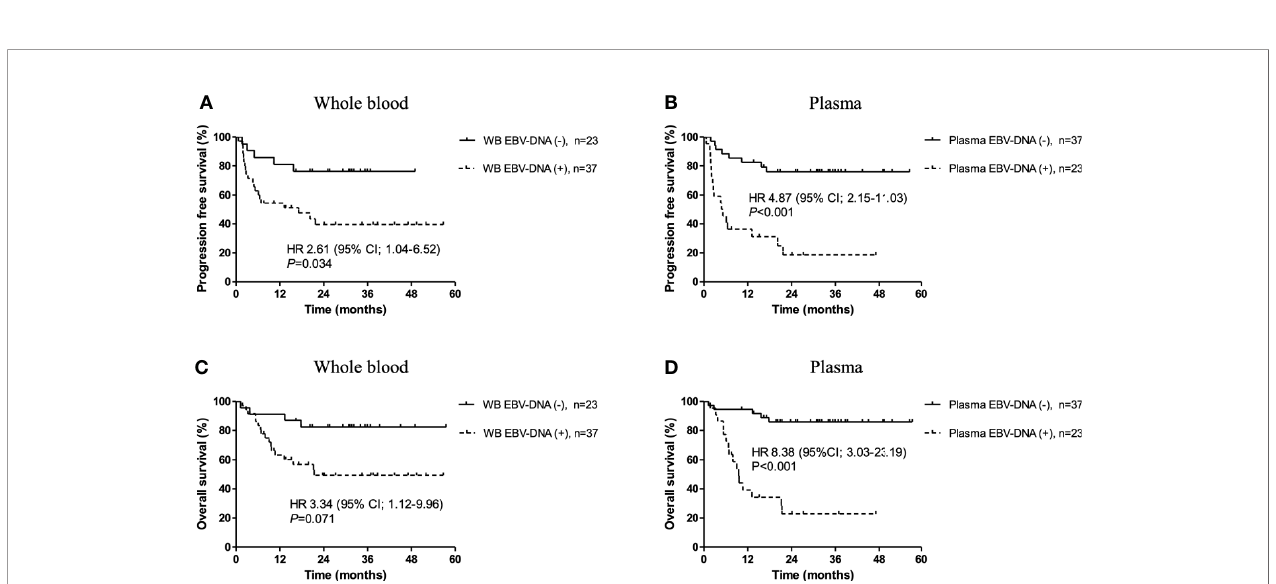
FIGURE 2 | Kaplan-Meier survival estimates strati fi ed by pre-treatment Epstein-Barr virus (EBV)-DNA status. Progression-free survival according to (A) whole blood and (B) plasma EBV-DNA status at diagnosis. Overall survival according to (C) whole blood and (D) plasma EBV-DNA status at pre-treatment.